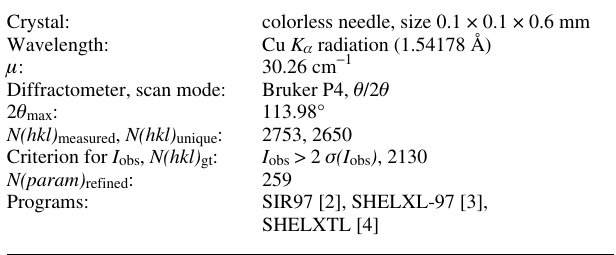
Table 1. Data collection and handling.